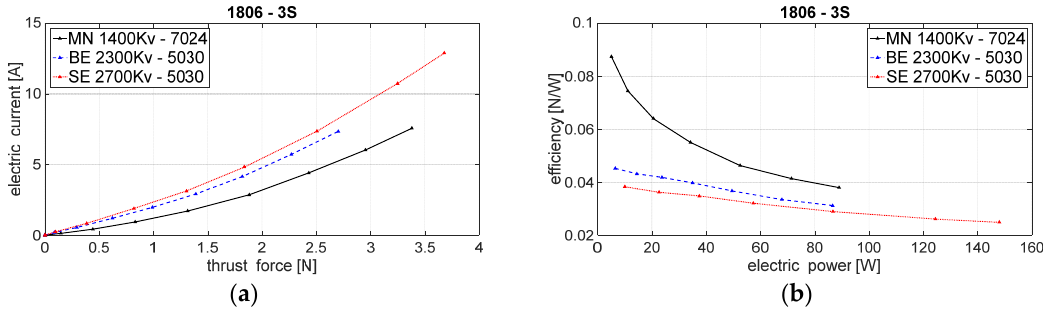
Figure 19. Energy consumption of 1806 BLDC series: ( a ) electric current with respect to thrust force; ( b ) overall efficiency.